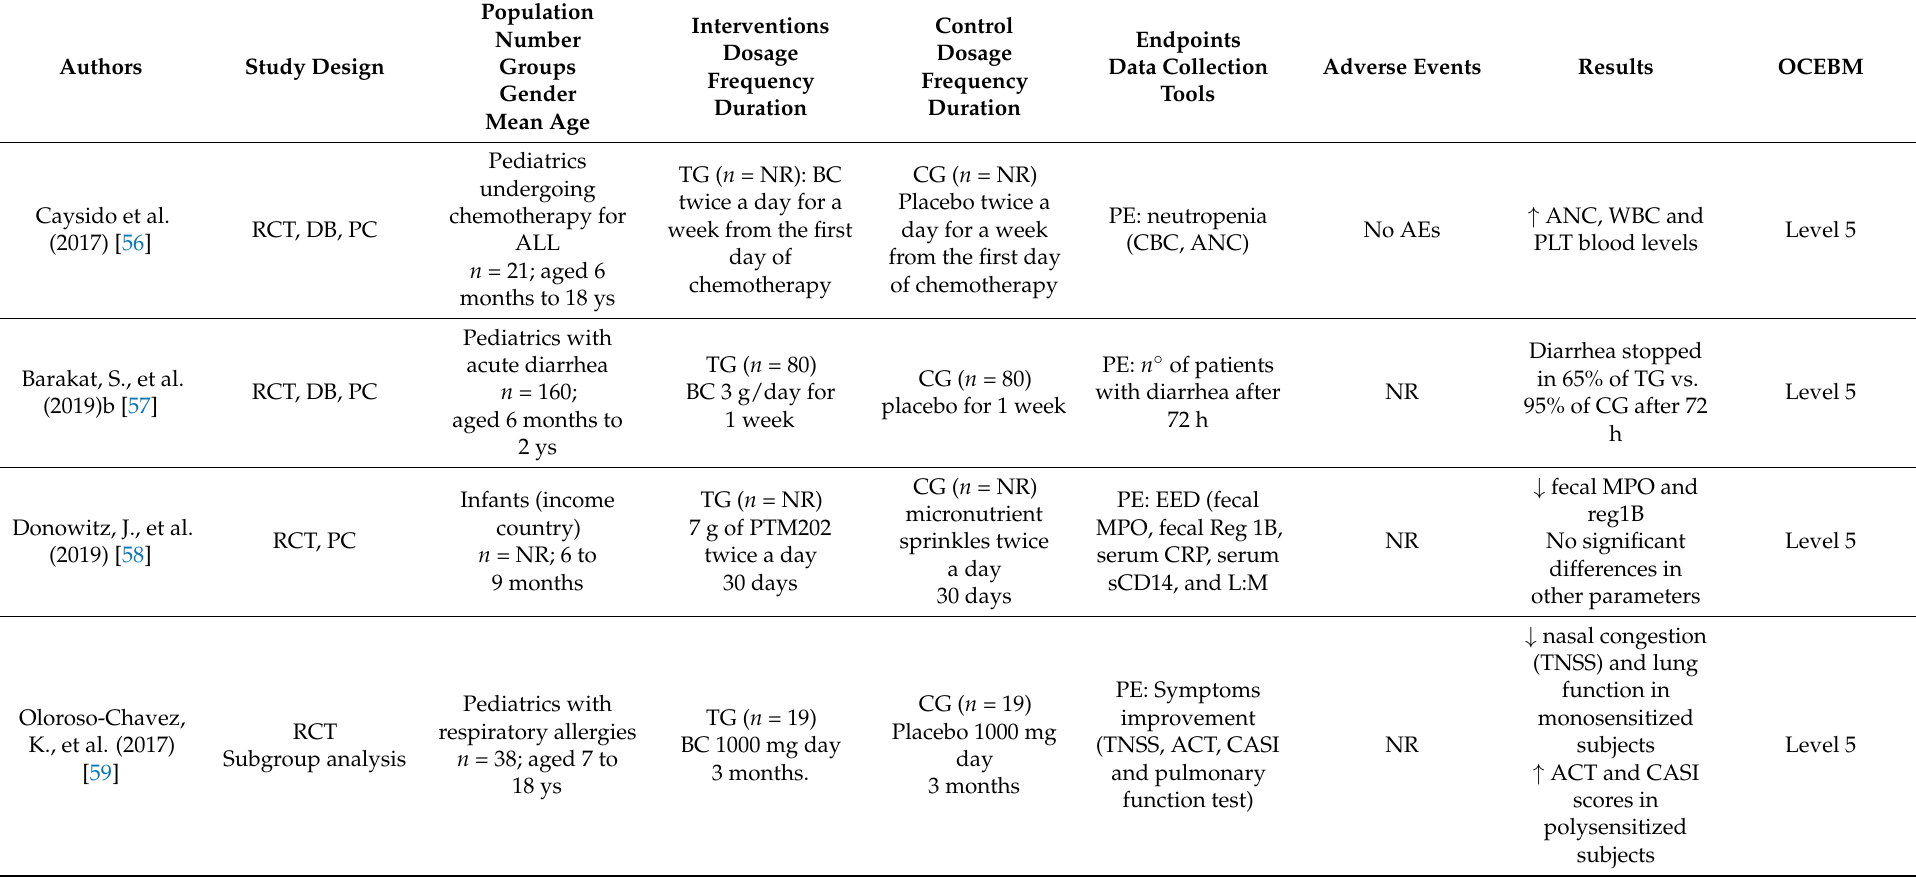
Table 7. Abstracts on BC clinical